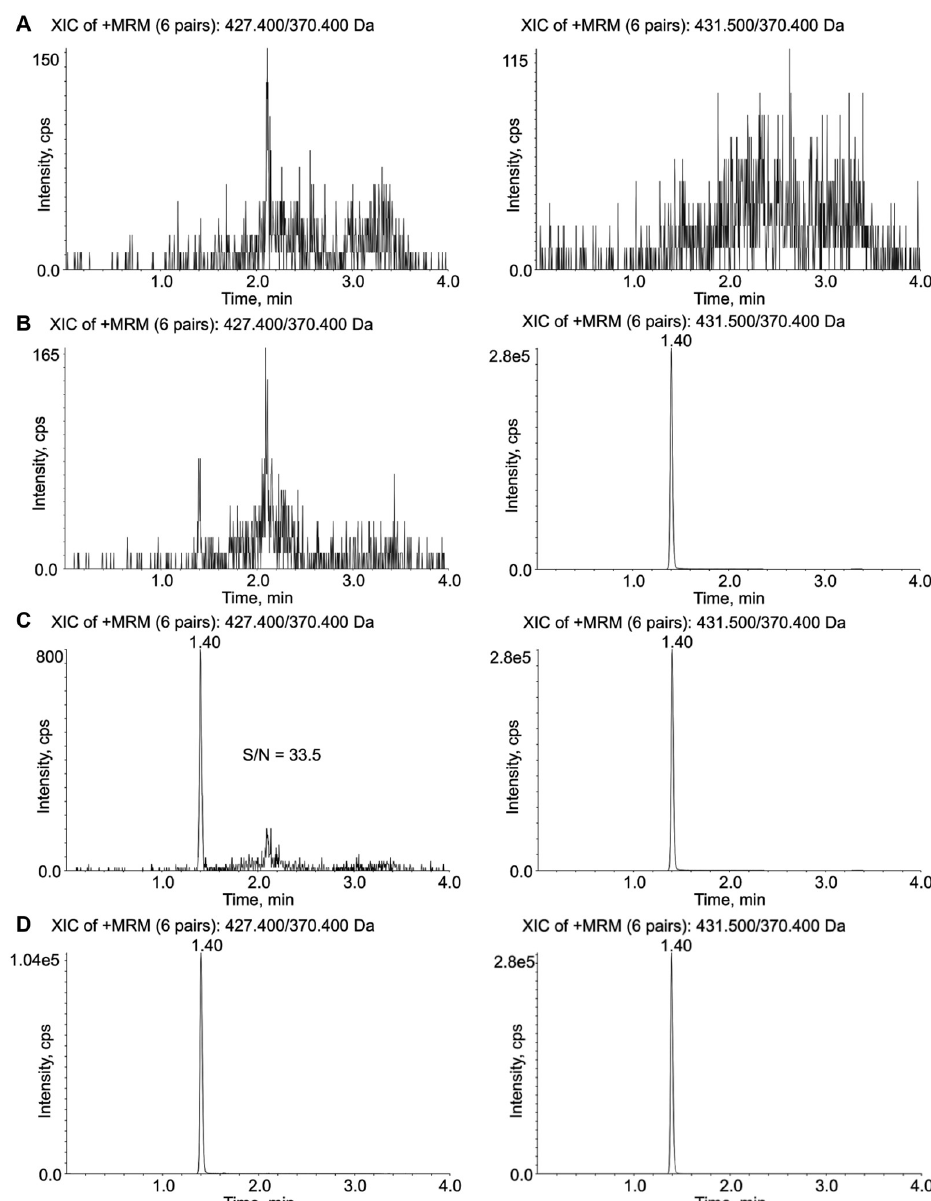
Fig 2. MRM chromatograms for LENVA (left panels) and internal standard (right panels). A: blank plasma sample; B: blank plasma sample with IS (50 ng/mL); C: LLOQ (0.50 ng/mL) with S/N value; D: MRM chromatograms of plasma sample from a patient treated with 12 mg/day LENVA and showing a drug concentration of 99.6 ng/mL.